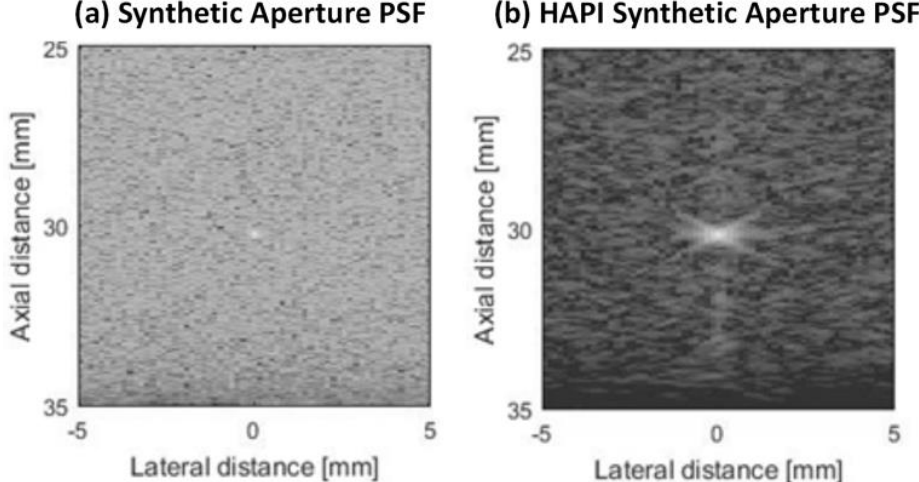
Figure 4. Point spread functions of ( a ) traditional synthetic aperture with 128 elements (128 transmit events), and ( b ) HAPI synthetic aperture with 128 non-zero-bit codes (1 transmit event) and band- width matching. For the same amount of noise added to the scattering data, HAPI-SA produces less noise in the resultant image. Images have a 55 dB dynamic range.